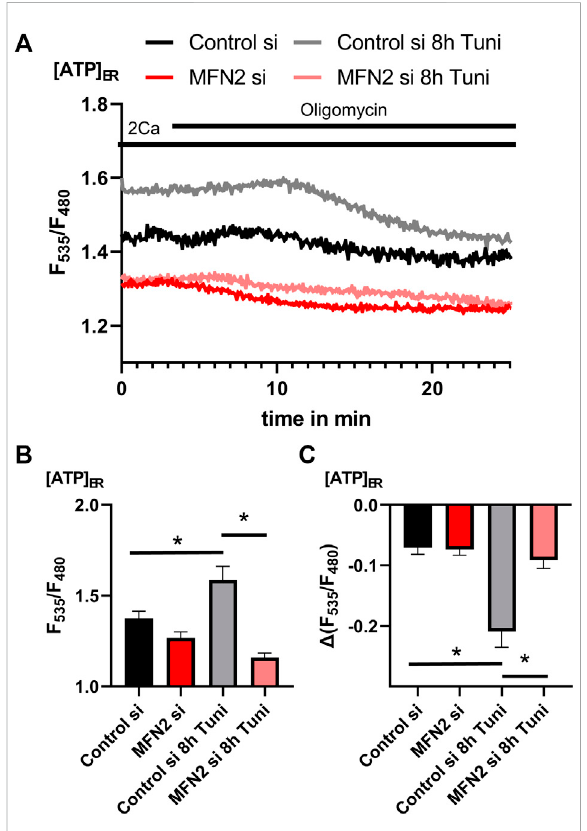
[ATP] ER of MFN2 silenced HeLa cells show no response on ER-stress. (A) HeLa cells transfected with siRNA against MFN2 or Control siRNAand expressing the endoplasmic reticulum targeted genetically encoded [ATP] ER sensor ERAT4.01 were used. Representative [ATP] ER traces upon oligomycin challenging of control HeLa cells or HeLa cells treated with 0.6 µM tunicamycin for 8 h. (B) Bar graphs (MEAN ± SEM) show basal [ATP] ER of control HeLa cells or HeLa cells treated with tunicamycin for 8 h transfected with siRNA against MFN2 or Control siRNA. (C) Bar graphs (MEAN ± SEM) show Δ [ATP] ER upon challenging control HeLa cells or HeLa cells treated with tunicamycin for 2 h transfected with siRNA against MFN2 or Control siRNA or 8 h with oligomycin (n control si/DMSO = 3/8/27; n control si/8h Tuni = 3/8/30; n MFN2 si/DMSO = 3/8/35; n MFN2 si/8h Tuni = 3/8/38). * p < 0.05 vs. respective control conditions carried out with one-way ANOVA with Tukey corrected posthoc